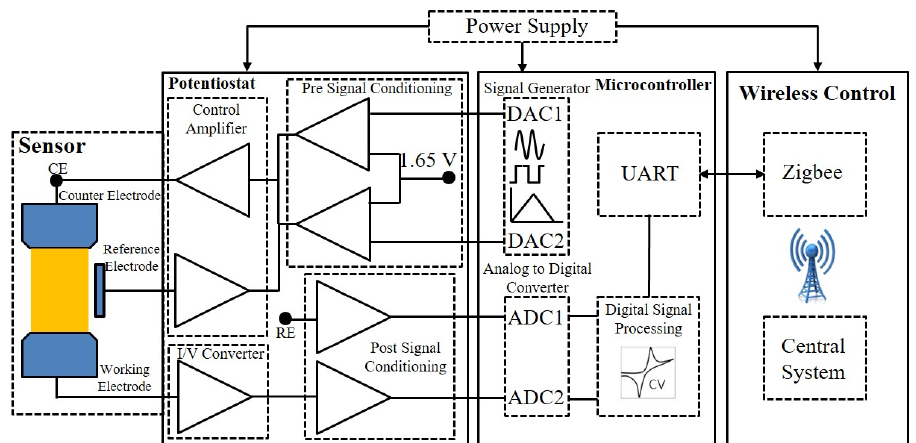
Figure 2. Block diagram with the components for MSTStat.